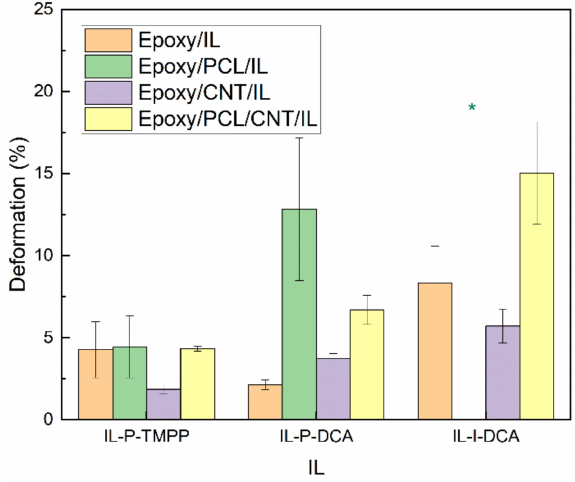
Figure 7. The deformation at break of the epoxy/PCL/CNT NCs cured with the three different ILs, as well as that of the reference epoxy/IL, epoxy/PCL/IL and epoxy/CNT/IL systems. * The specimen slipped and did not break.